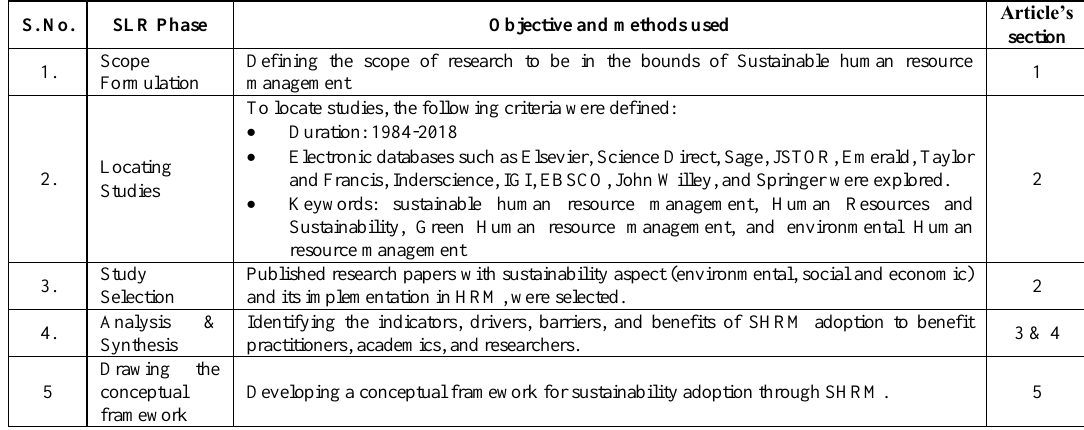
Table 1. Systematic literature review